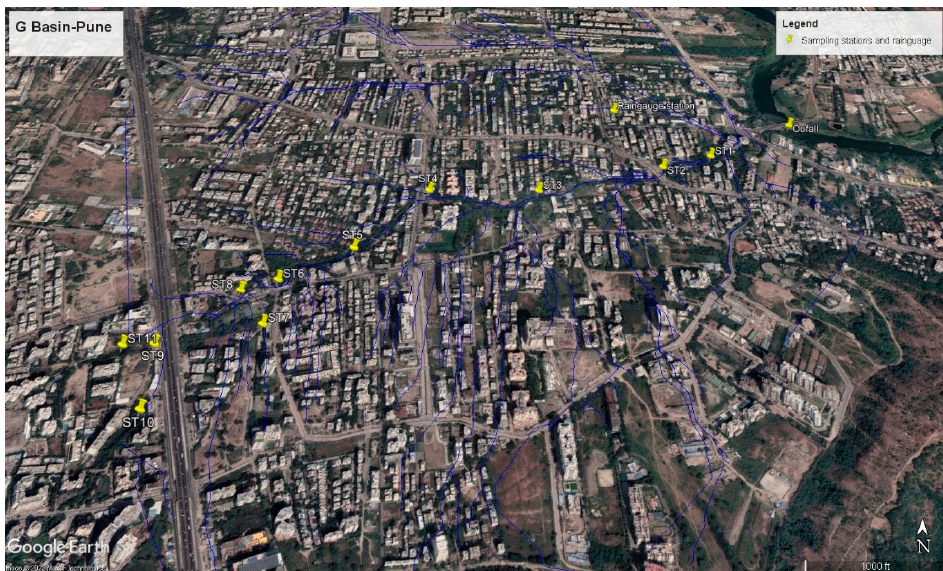
Figure 3. Main natural stream in Baner-showing 11 sampling locations along with an outfall location on river Mula. (Google Earth Image).